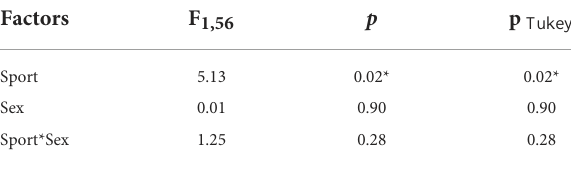
TABLE 1 The 2 × 2 ANOVA outputs on advanced progressive matrices